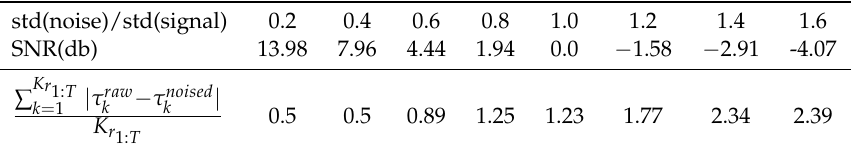
Table 2. Error on τ 1: K with respect to noise level.